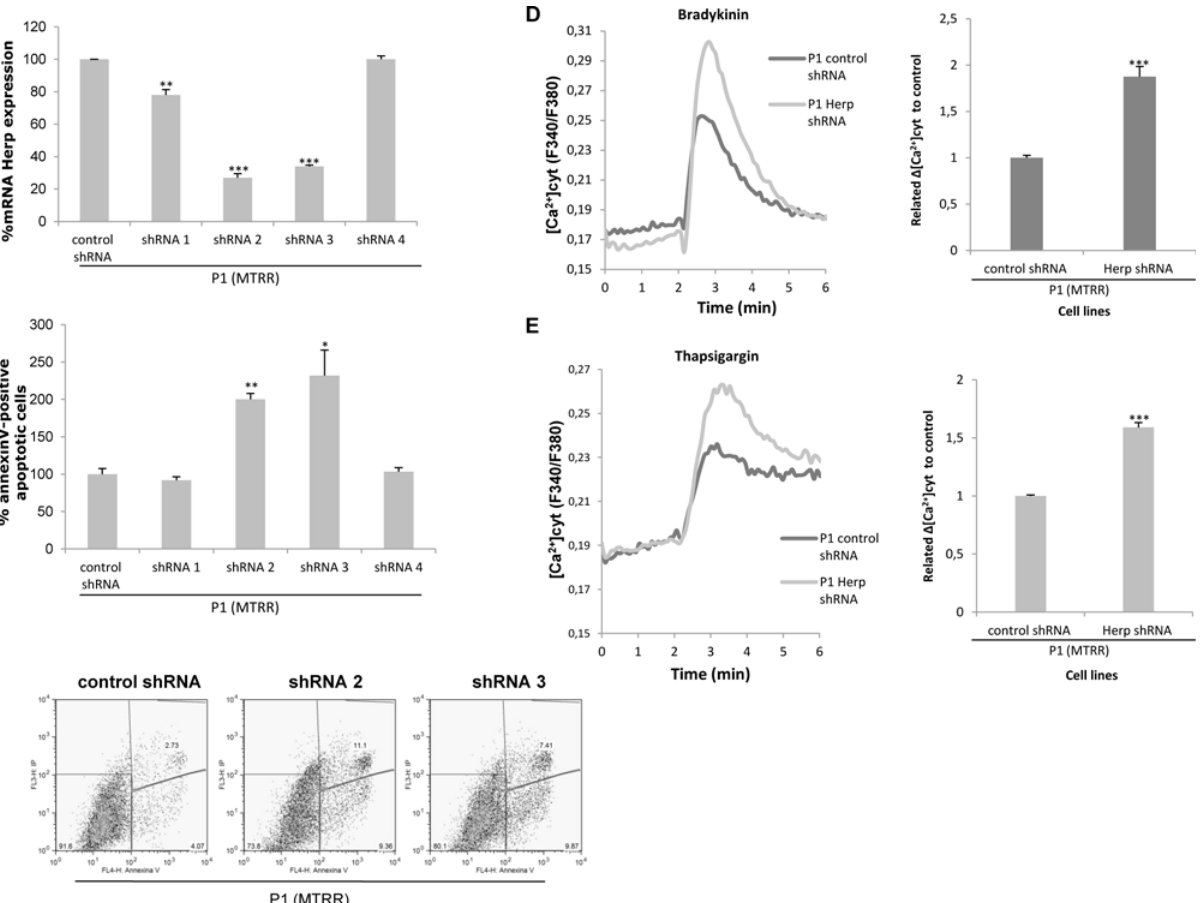
Fig 3. Analysis of mRNA expression, apoptosis and intracellular Ca 2+ levels after HERP gene silencing in P1 fibroblasts. (A) Quantification of Herp mRNA expression by qRT-PCR. Quantities are shown as % Herp mRNA expression relative to fibroblasts infected with non-target control shRNA in P1 cells. Data represent mean ± standard deviation of three independent experiments. (B) Apoptosis detection by flow cytometry. Percentage of annexin V-positive apoptotic cells in Herp shRNAs and non-target control shRNA relative to total cell number per sample. Data represent mean ± standard deviation of two independent experiments, each performed by triplicate. shRNA1, shRNA2, shRNA3 and shRNA4 indicate Herp shRNAs targeting different sequences of human Herp used in this study for the generation of lentiviral particles and infection of fibroblasts. (C) Dot blots from a representative experiment of apoptosis levels in P1 fibroblasts infected with Herp shRNA2 and shRNA3 and control shRNA are shown. (D) Representative recording showing levels of intracellular Ca 2+ before and after addition of 10 μ M bradykinin (BK) in control shRNA and knockdown Herp P1 cells. Results were obtained from two independent ffiffiffiffiffi p 21 experiments. Data represent mean ± SEM (standard error of the mean = SD/ ). ( E) Representative recording showing levels of intracellular Ca 2+ prior to and after exposure of control shRNA and knockdown Herp P1 cells to 1 μ M thapsigargin (Thap). Results were obtained from two independent experiments. ffiffiffiffiffi p 21 Data represent mean ± SEM (standard error of the mean = SD/ ). * P < 0.05; ** P < 0.01; *** P < 0.001.